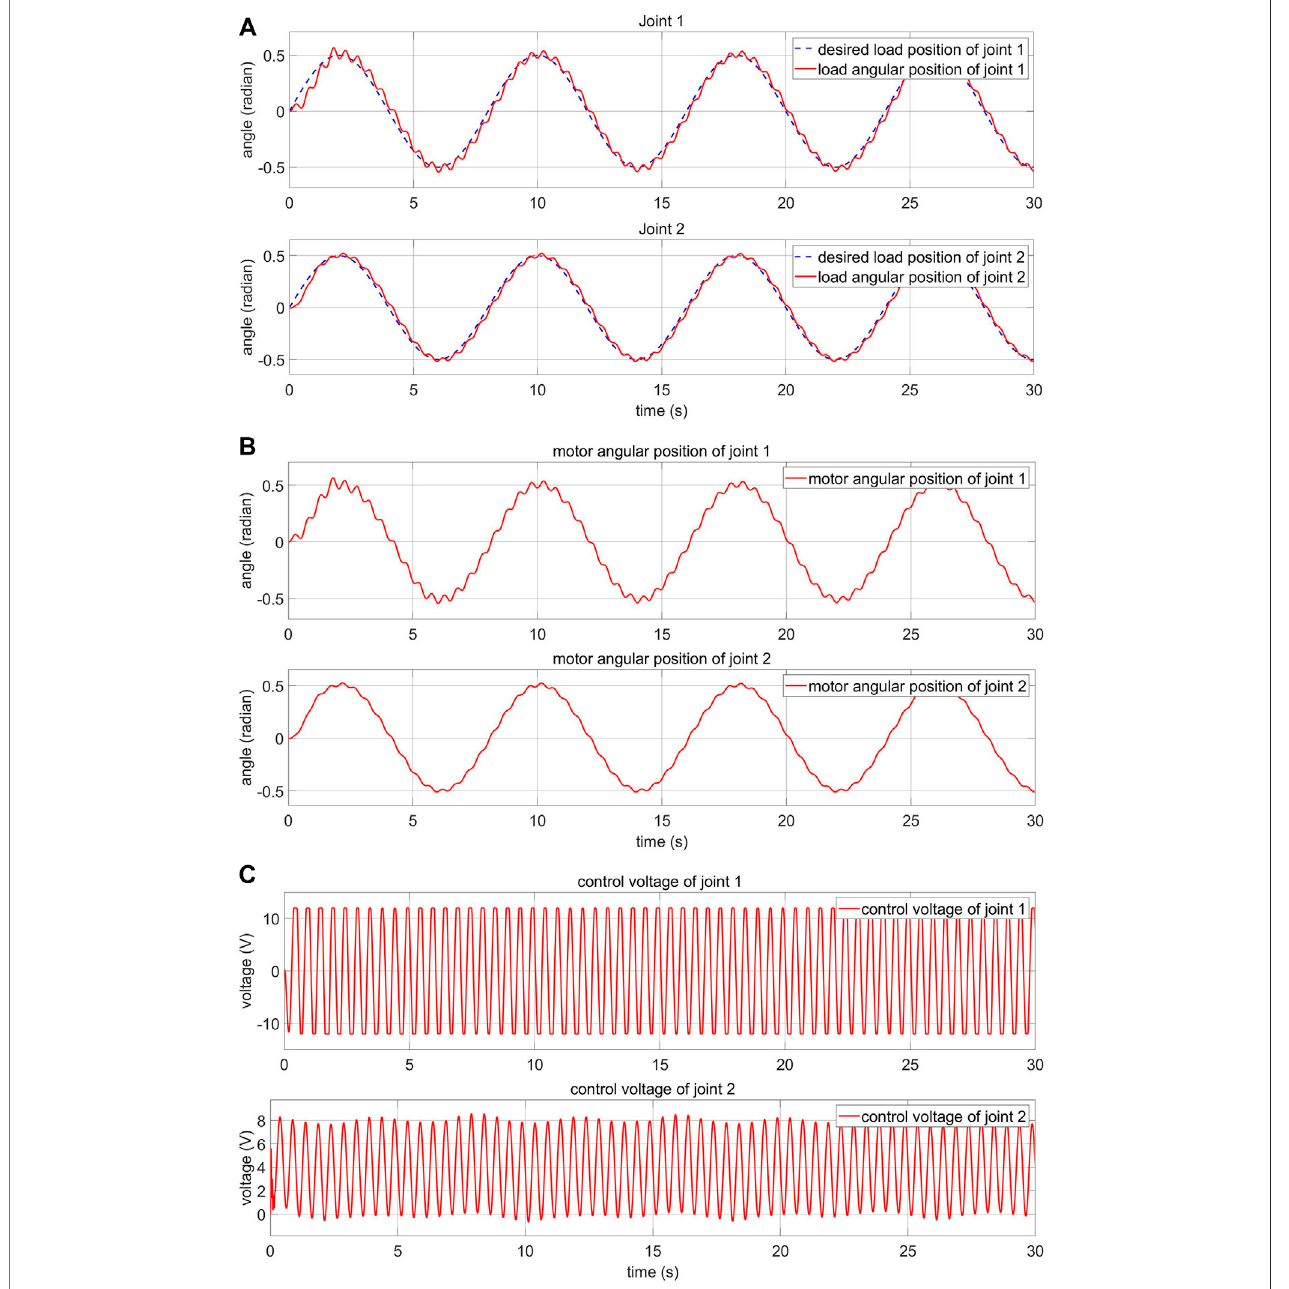
FIGURE 12 | Response of the FPIC-MRAC of the robot arm with external disturbance (A) load-side response (B) motor-side response (C) motor control voltage.